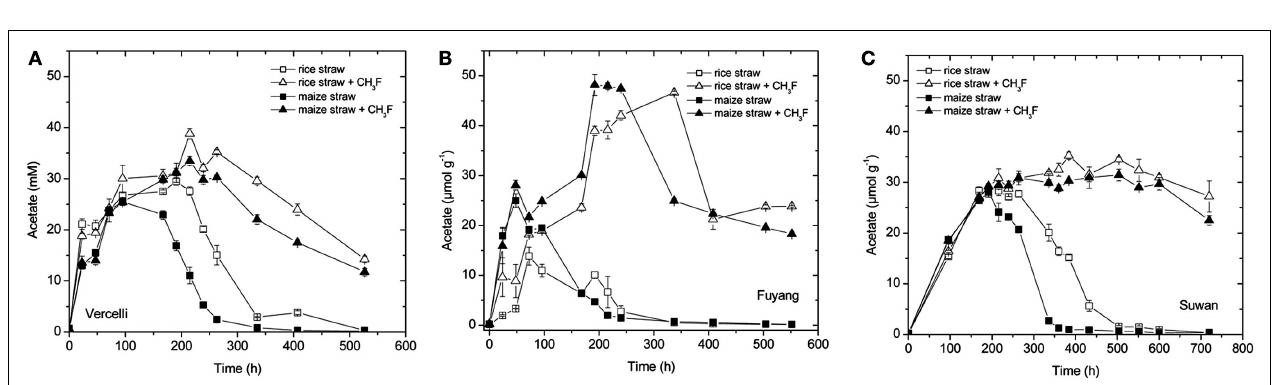
under anoxic conditions in the absence or presence of CH 3 F (1, 2, and 2% inVercelli, Fuyang, and Suwan soil, respectively); mean ± SE, n = 3.